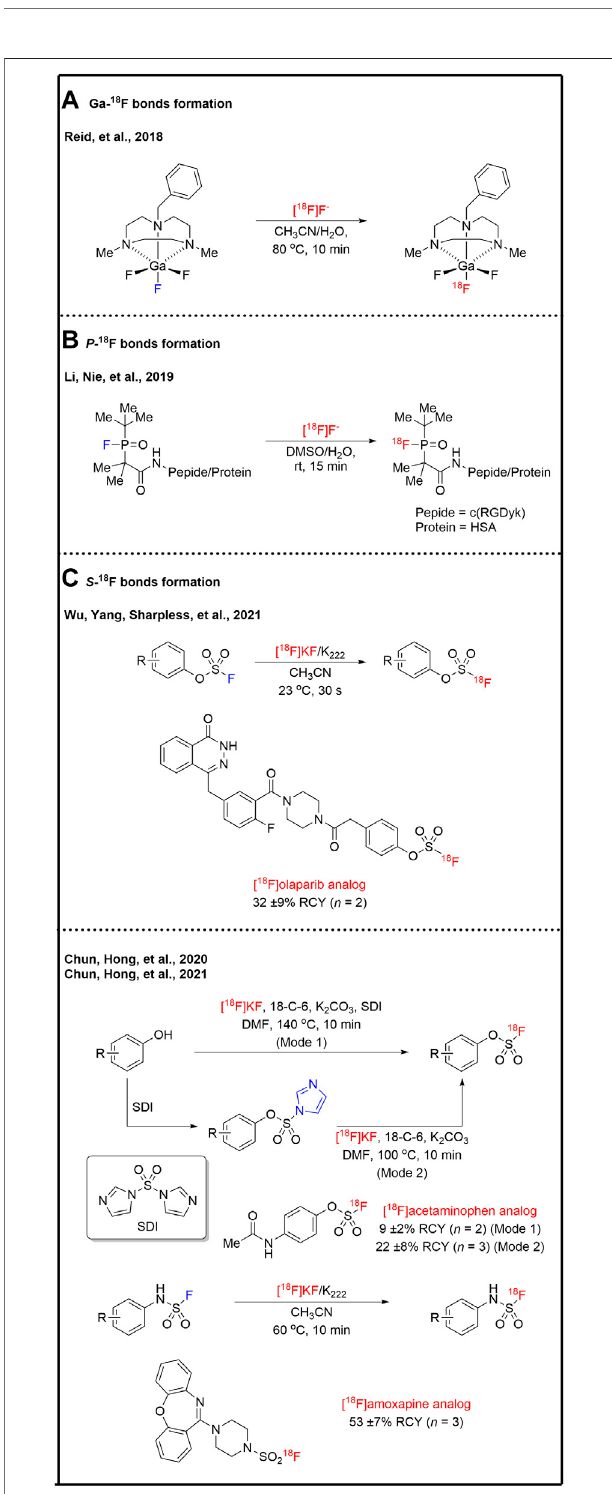
FIGURE 5 | Heteroatom- 18 F bonds